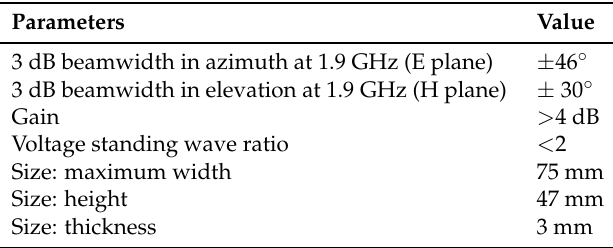
Table 2. The key parameters of microstrip antennas.